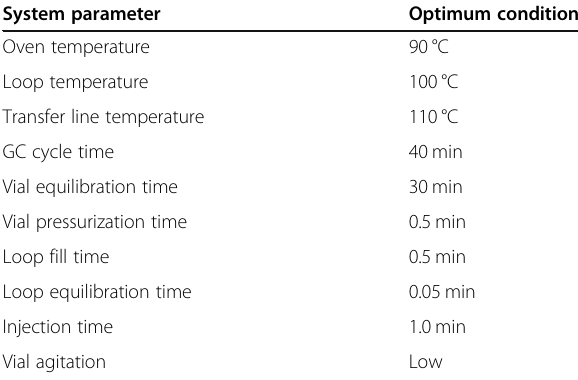
Table 3 Optimized headspace conditions